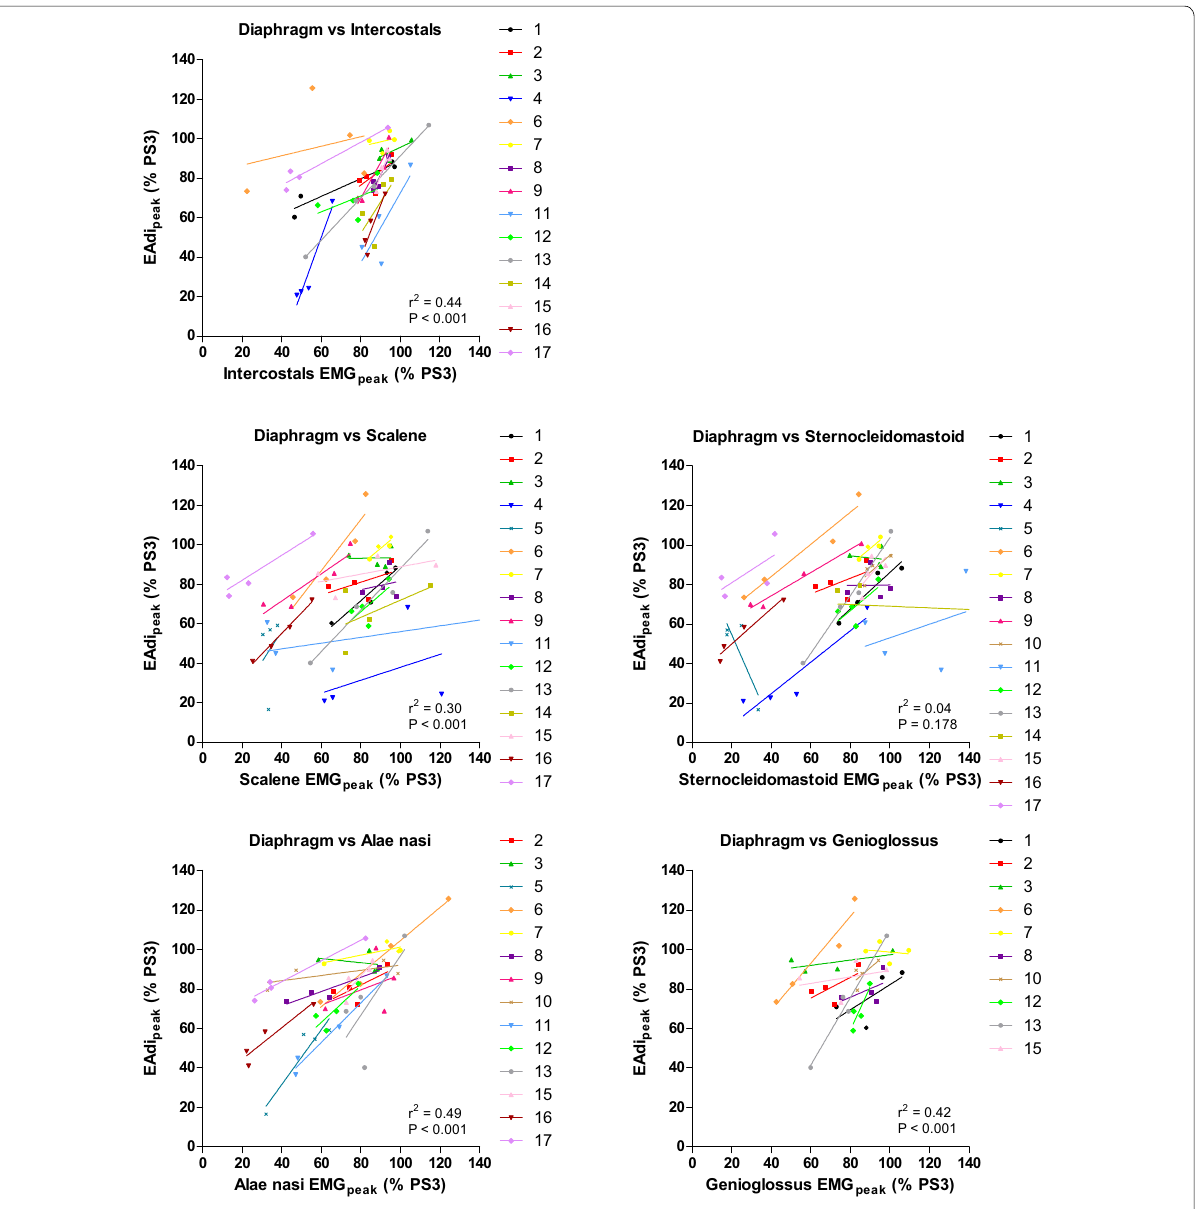
Fig. 2 Relation between diaphragm and extradiaphragmatic inspiratory muscle activity for pressure support (PS) level 15, 12, 9 and 6 cmH 2 O, with peak electrical activity of the diaphragm (EAdi peak ) and peak electromyography (EMG peak ) normalized to muscle activity at PS level 3 cmH 2 O (% PS3). Each individual patient is depicted in a specific color and marker. The regression lines describing the relation on individual patient level are depicted, from which the high variability among patients is clear. 3 points are not shown (PS 6 patient 11 for scalene (scalene EMG peak 298% PS 3 at EAdi peak 87% PS 3) and PS 12 and 9 patient 14 for sternocleidomastoid (sternocleidomastoid EMG peak 153 and 386% PS 3 at EAdi peak 45 and 62% PS 3, respectively), as values were off scale. However, the regression lines shown include these data